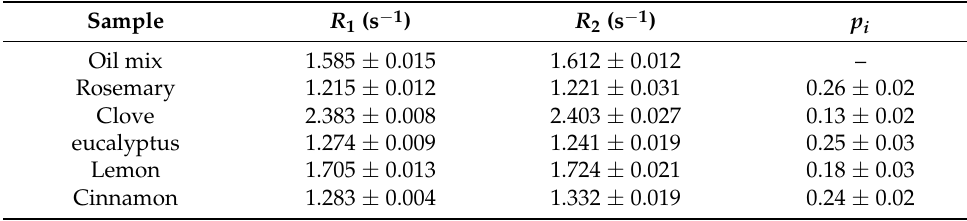
Table 2. The values of spin–lattice and spin–spin relaxation rates in the investigated oils ( R — relaxation rate; p i —fraction of